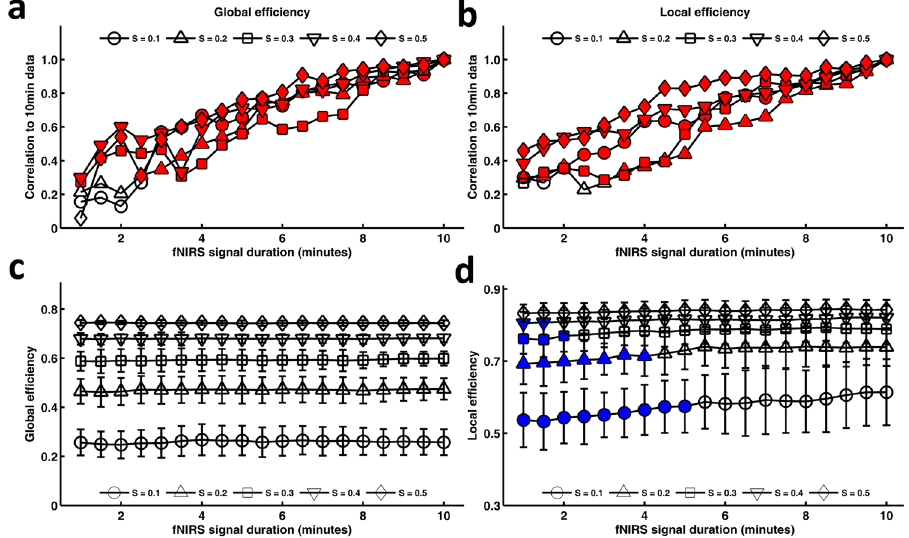
Figure 4. Effect of fNIRS signal acquisition duration on the accuracy and stability of global efficiency and local efficiency. The plots of the correlation strength calculated for global efficiency ( a ) and local efficiency ( b ) between short and long (10.0 min) signal durations. The red-filled circles indicate a significant correlation between global/local efficiency calculated with short and long (10.0 min) fNIRS signal acquisition durations. For both global and local efficiency, the analyses revealed significant ( P < 0.001) and strong correlations for almost all threshold conditions. Magnitudes of the global efficiency ( c ) and local efficiency ( d ) plotted according to the duration of the fNIRS signal acquisition (1.0~10.0 min with 30-sec bins). The blue-filled shapes indicate a significant difference in the magnitude of the computed value associated with a given fNIRS signal acquisition duration compared with the magnitude when computed using 10.0 min of fNIRS